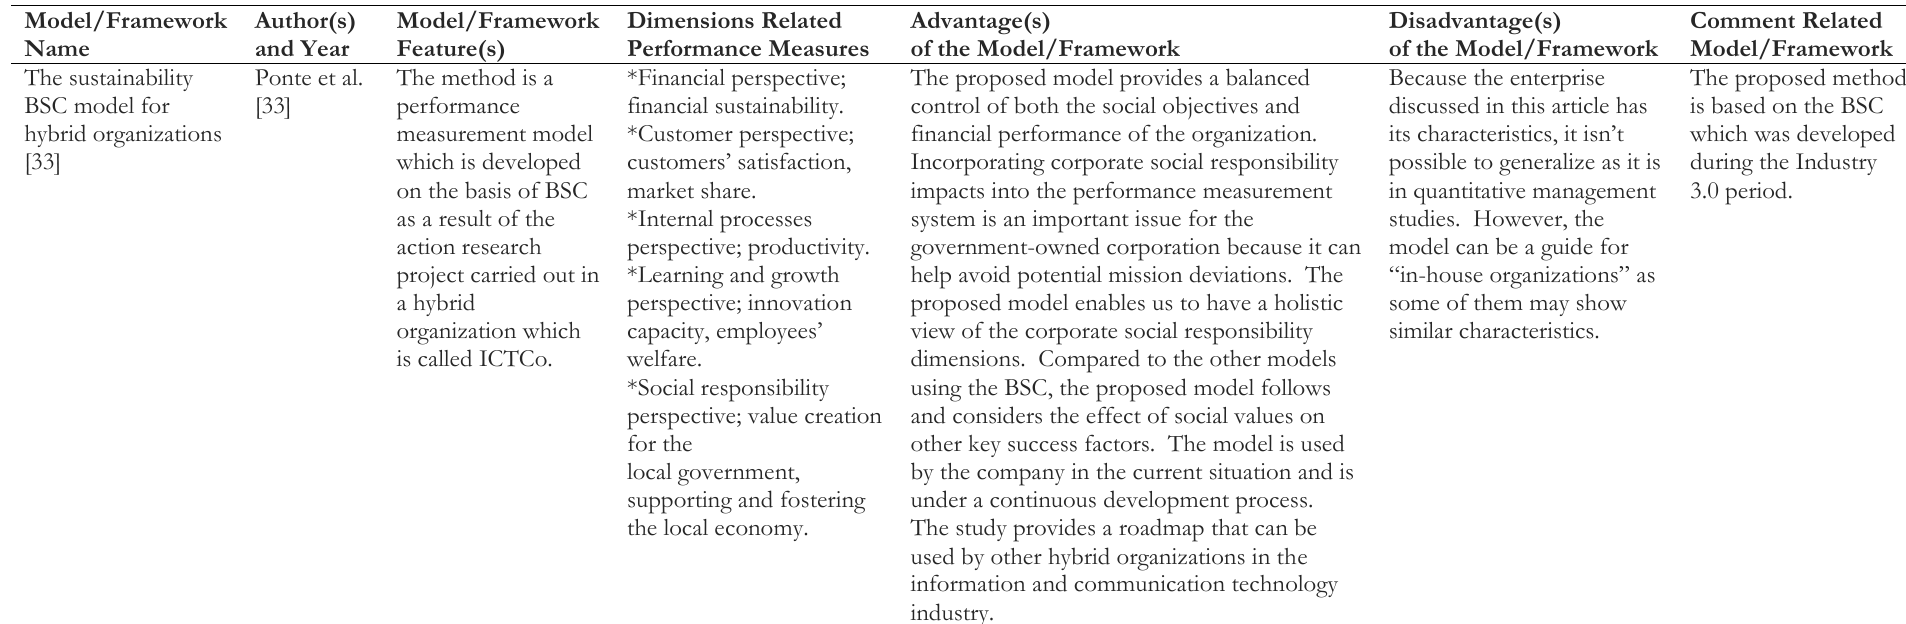
Table 18. Organizational performance measurement models developed in Industry